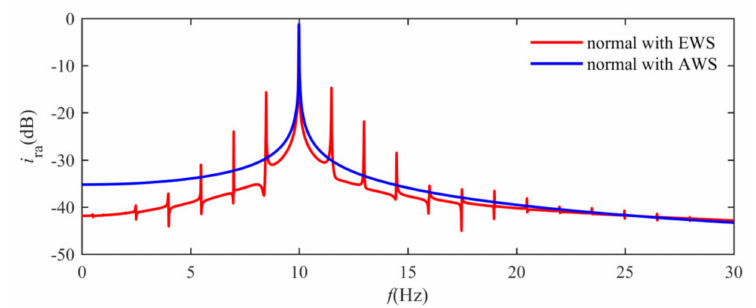
Figure 7. Stator current comparison on normal condition.